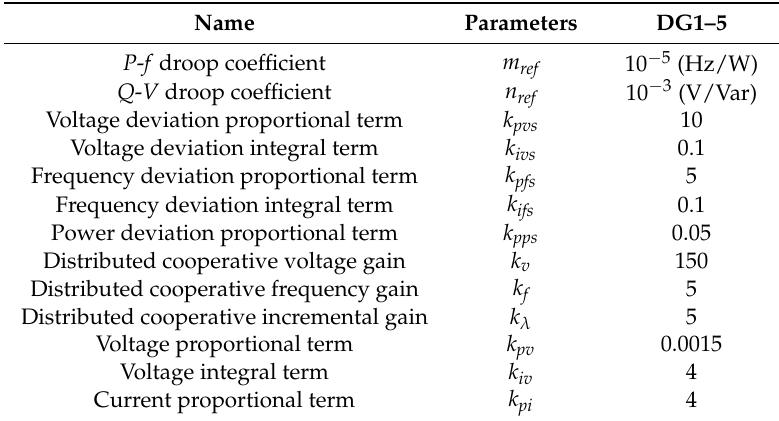
Table 1. Specifications of the microgrid system.